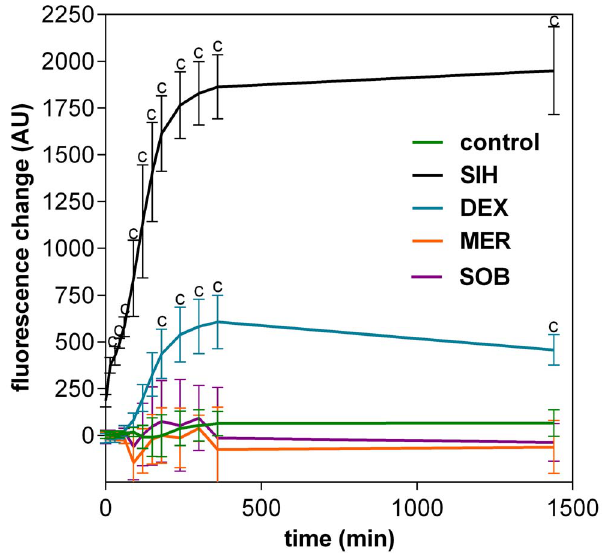
Figure 7. Intracellular iron chelation properties. The intracellular iron (Fe) chelation by dexrazoxane (DEX), sobuzoxane (SOB) and merbarone (MER) was measured as the rate of Fe displacement from the Fe-calcein complex in H9c2 cardiomyoblast cell line. The change of fluorescence of the intracellular-trapped calcein in the H9c2 cells loaded with 100 m M ferric-ammonium citrate was assessed after adding the studied substances (100 m M) as described in Materials and methods section. The experimental strong Fe chelator SIH was used as a positive control. Data from 4 independent experiments are expressed as mean 6 SD. Statistical significance: Two-way ANOVA Dunnet’s post-hoc test, P # 0.05; c–compared to control.